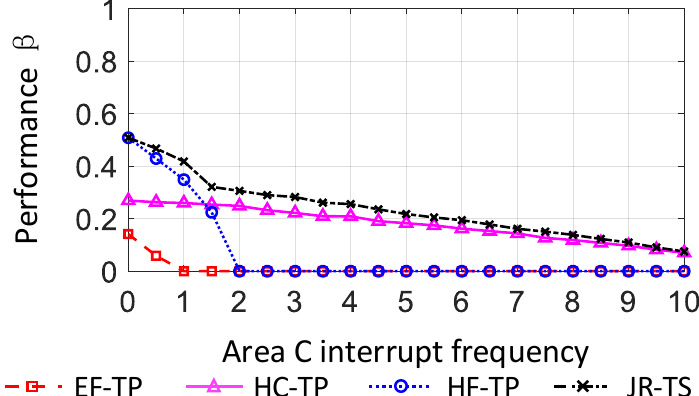
Figure 17. Normalized performance coefficient with dynamically set